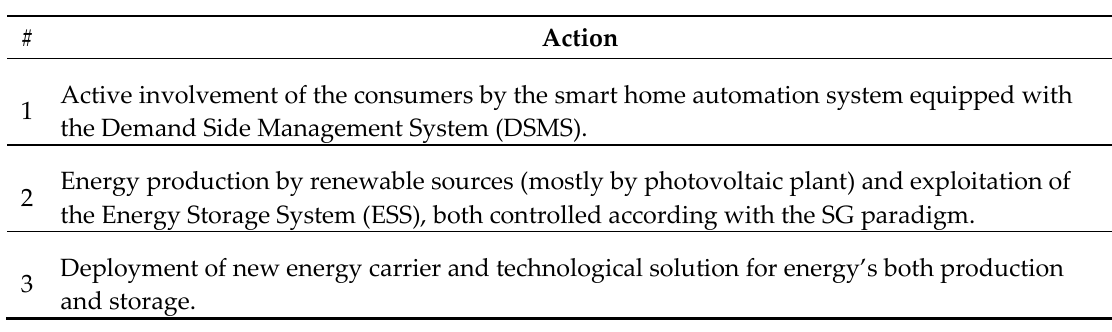
Table 2. Mainstays of the